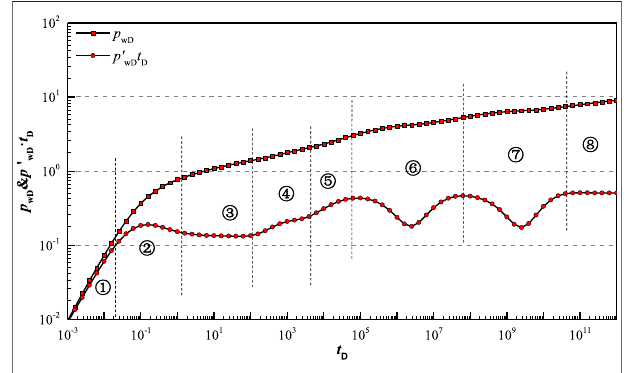
FIGURE6| PressuretransienttypecurveofinclinedwellinFVCHRswith triple-porosity dual-permeability behavior ( C D (cid:2) 0 . 1 , S (cid:2) 0 . 1 , h (cid:2) 100 , h w (cid:2) h / cos ( ψ ′ ) , r w (cid:2) 0 . 1 , θ w (cid:2) 75 o , k hv (cid:2) 1 , k D (cid:2) 1 , κ (cid:2) 0 . 7 , ω f (cid:2) 0 . 01 , ω V (cid:2) 0 . 1 , λ